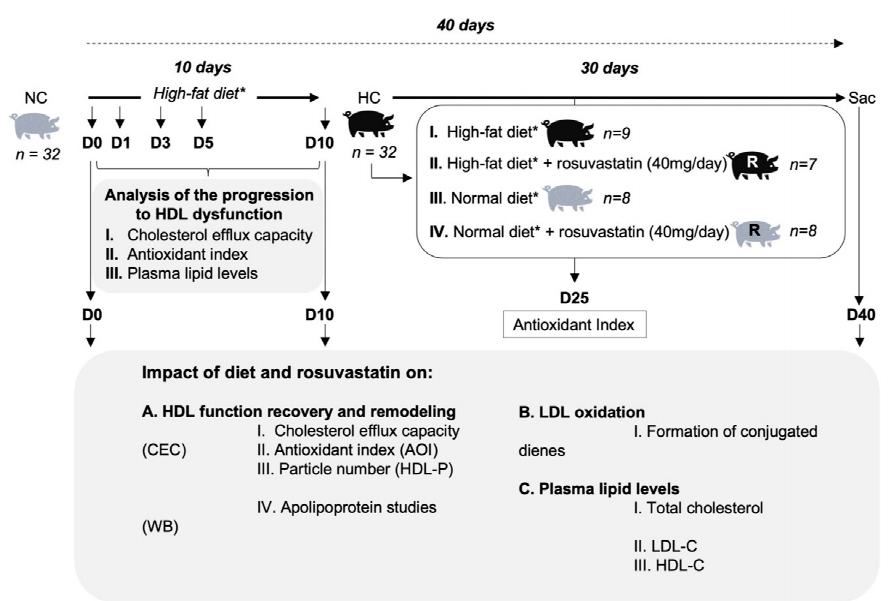
Figure 5 Study design. All animals were fed a hypercholesterolemic diet for the first 10 days of the study. From this day onwards, the animals were randomly divided into four groups to receive 30 days of (I) hypercholesterolemic diet alone (n = 9), (II) hypercholesterolemic diet with 40 mg rosuvastatin daily (n = 7), (III) normocholesterolemic diet alone (n = 8), (IV) normocholesterolemic diet with 40 mg rosuvastatin daily (n = 8). Samples were collected at indicated timepoints. HDL: high ‐ density lipoprotein; CEC: cholesterol efflux capacity; AOI: antioxidant index; WB: Western blot. * High ‐ fat and normal diet refer to hypercholester ‐ olemic and normocholesterolemic diet, respectively.